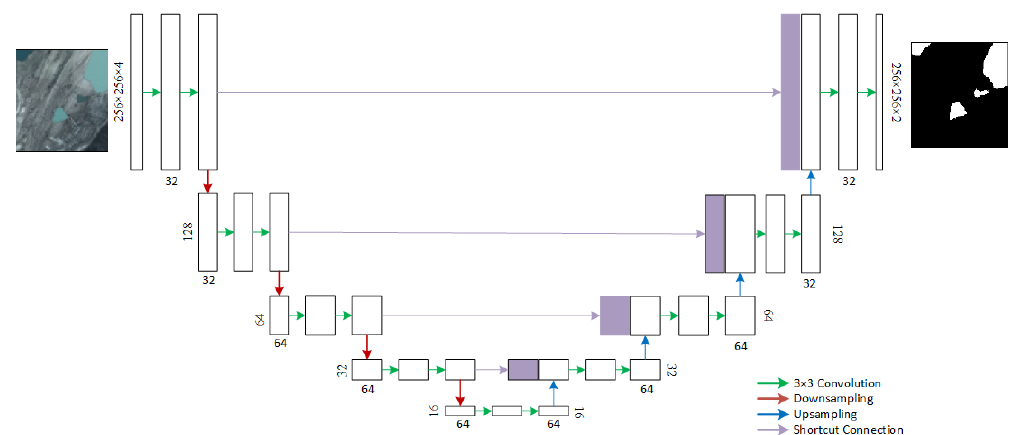
Figure 4. U-Net architecture with Visual Geometry Group (VGG)-style convolution layers. The input is a 4-band PlanetScope image. The output is a 2-band image containing the probability of each class for each pixel. The shortcut connection is used to concatenate the activations from encoder units with the corresponding decoder